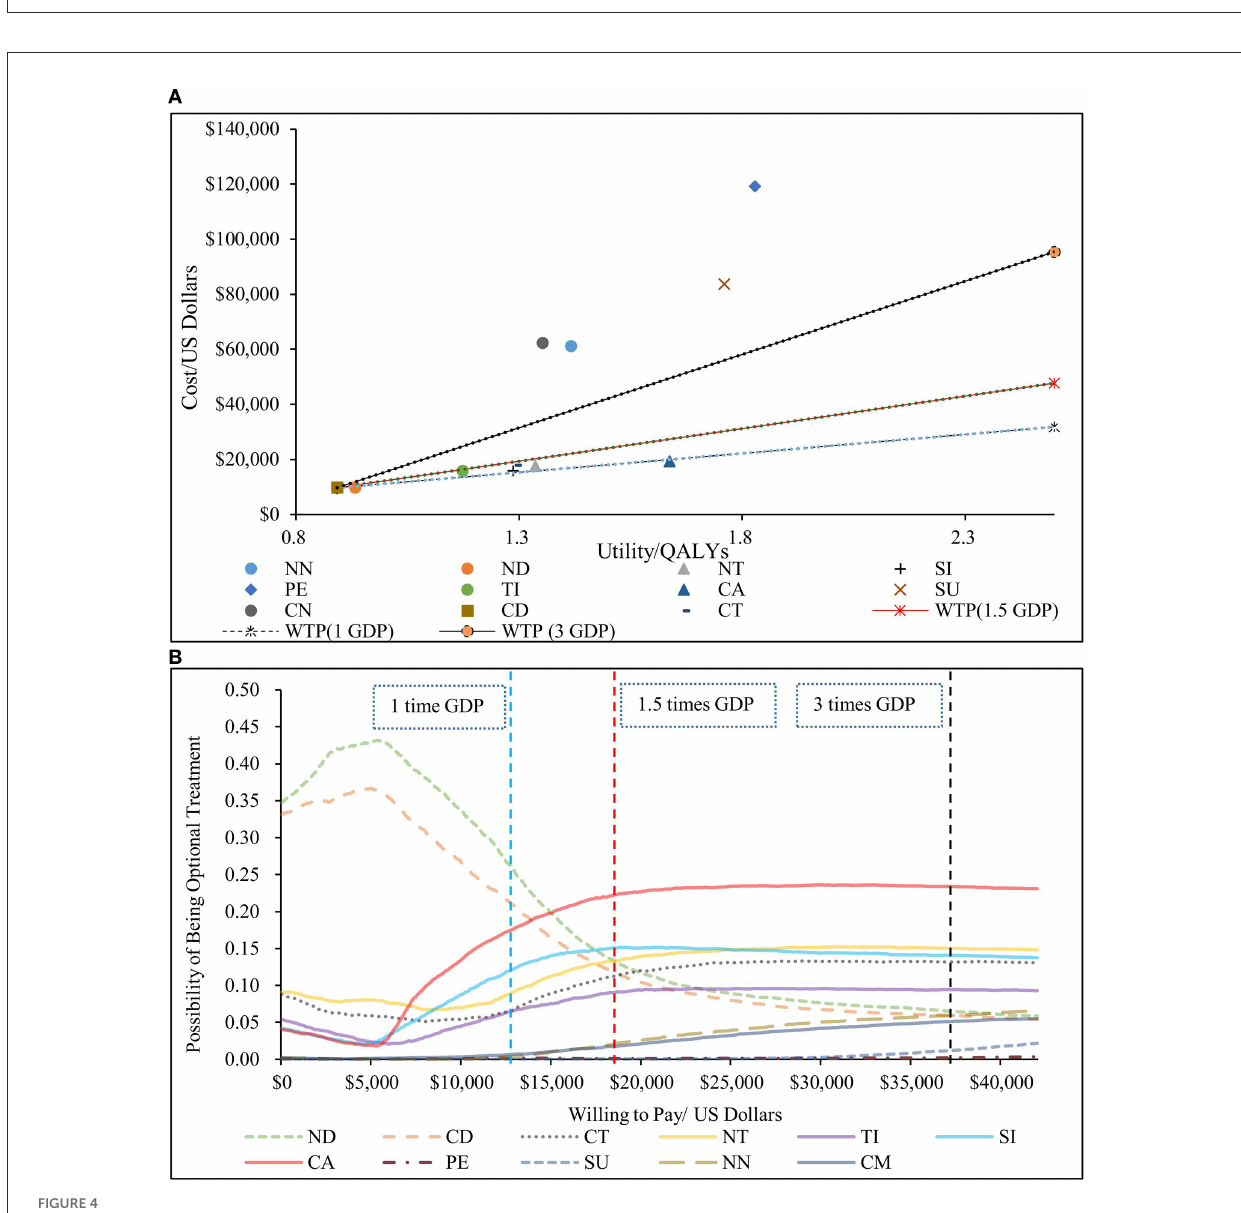
evaluated the combination of pembrolizumab with chemotherapy and chemotherapy in patients with EGFR or ALK mutation- negative sq-NSCLC, and showed that the combination